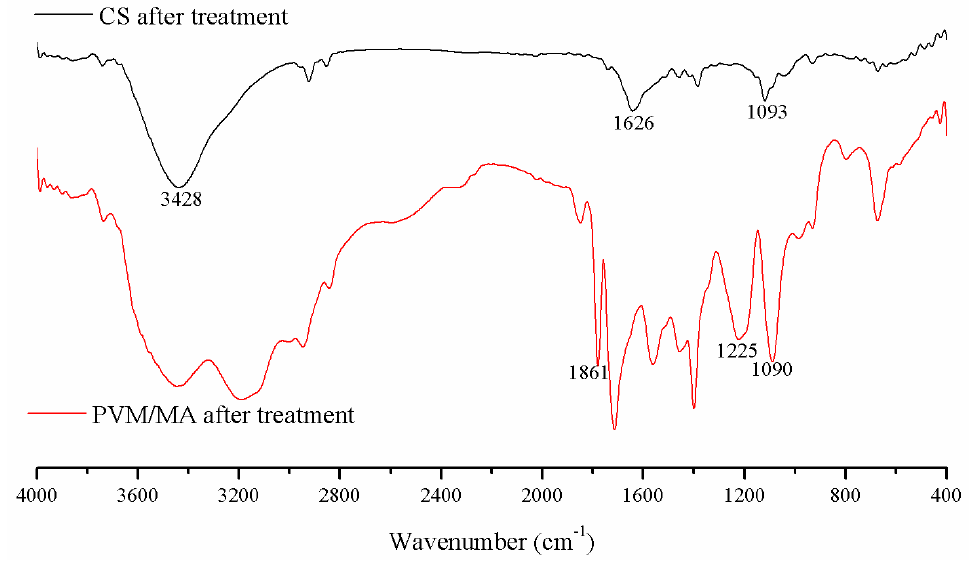
Figure 4. FTIR spectra of chitosan (CS) and poly-(methyl vinyl ether-co-maleic anhydride) (PVM/MA) after the SCF